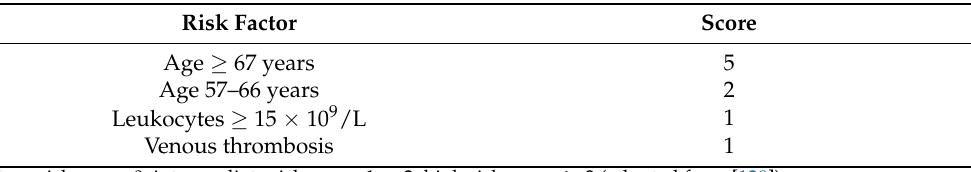
Table 2. Stratification of risk of survival in polycythaemia vera according to the classical risk score.